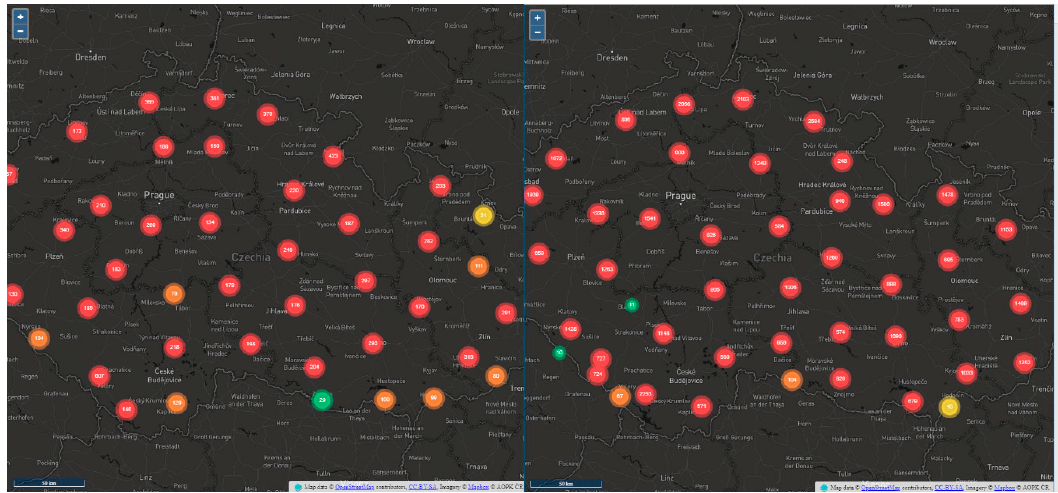
Figure 4. Map output of OpenLayers—testing on 10,000 and 50,000 of points.